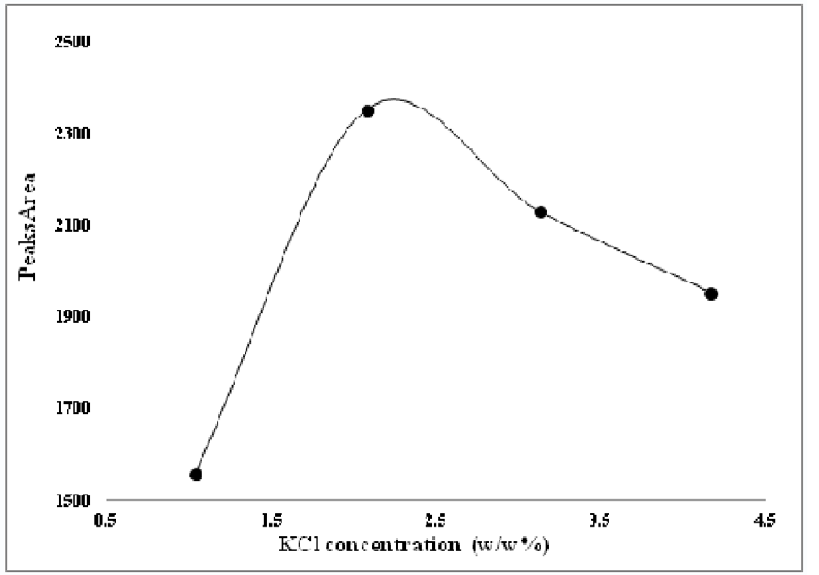
Figure 3. Variation of total phenolic compounds versus KCl salt concentration for selection of optimum ionic strength.